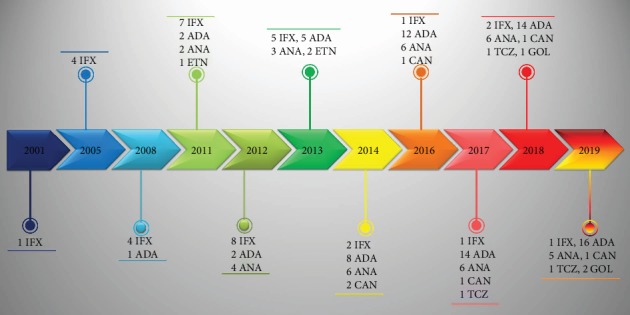
Timeline graph illustrating the different biologic treatments administered to our patients over time. List of abbreviations: ADA: adalimumab; ANA: anakinra; CAN: canakinumab; ETN: etanercept; GOL: golimumab; IFX: infliximab; TCZ: tocilizumab.